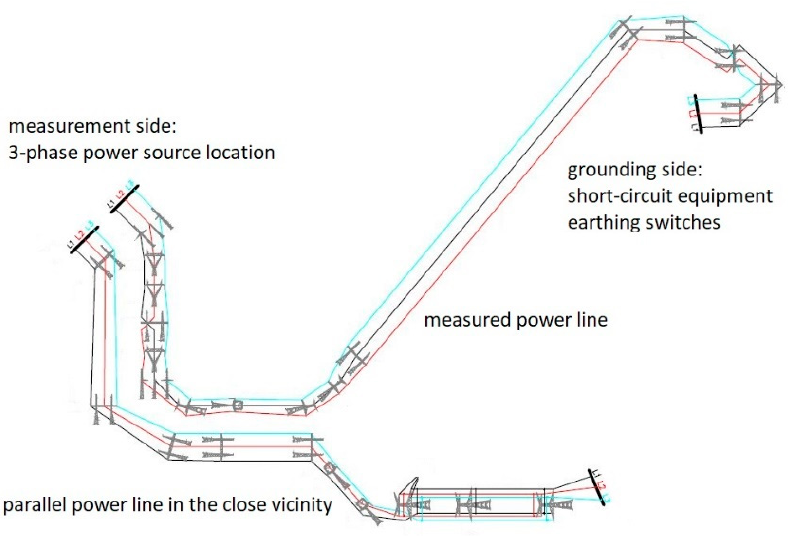
Figure 9. Simplified picture of the route and schedule of measured transmission power line.